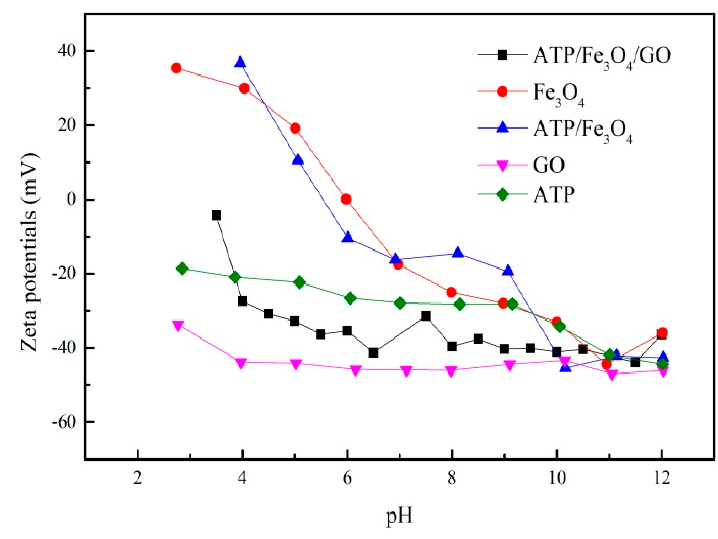
Figure 2. The zeta potentials of ATP, GO, Fe 3 O 4 , ATP/Fe 3 O 4 , and ATP/Fe 3 O 4 /GO.